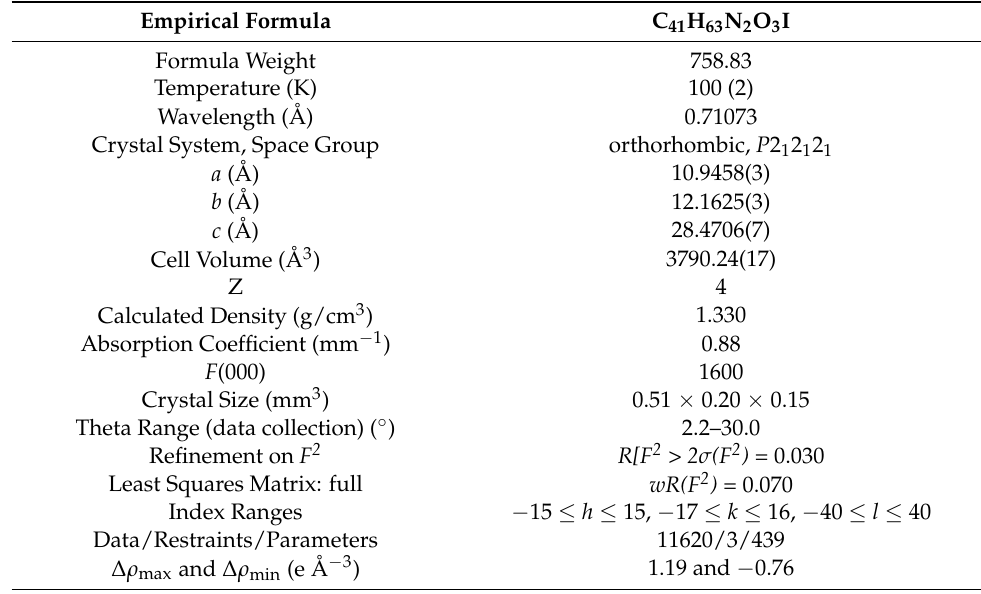
Table 1. The crystal data, data collection and refinement for 1